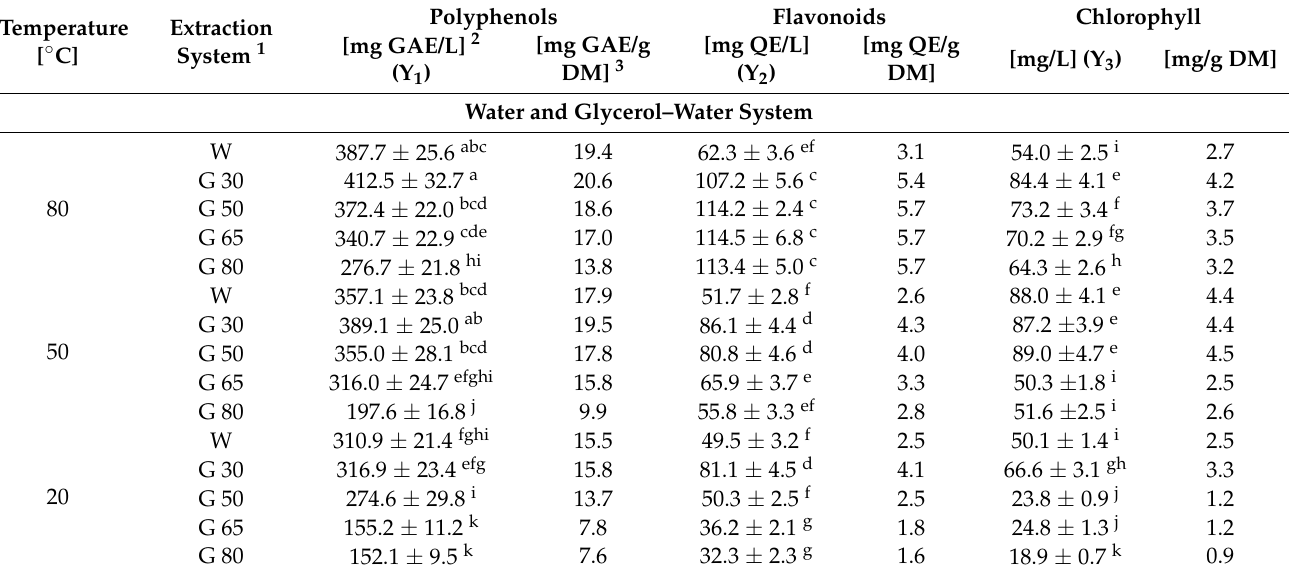
Table 2. Content of polyphenols, flavonoids and chlorophyll in extracts from peppermint.